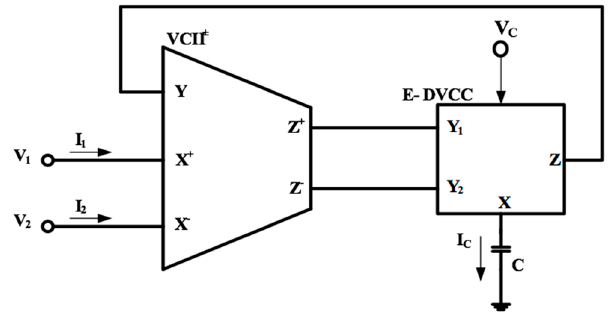
Figure 1. The proposed floating positive capacitance multiplier.